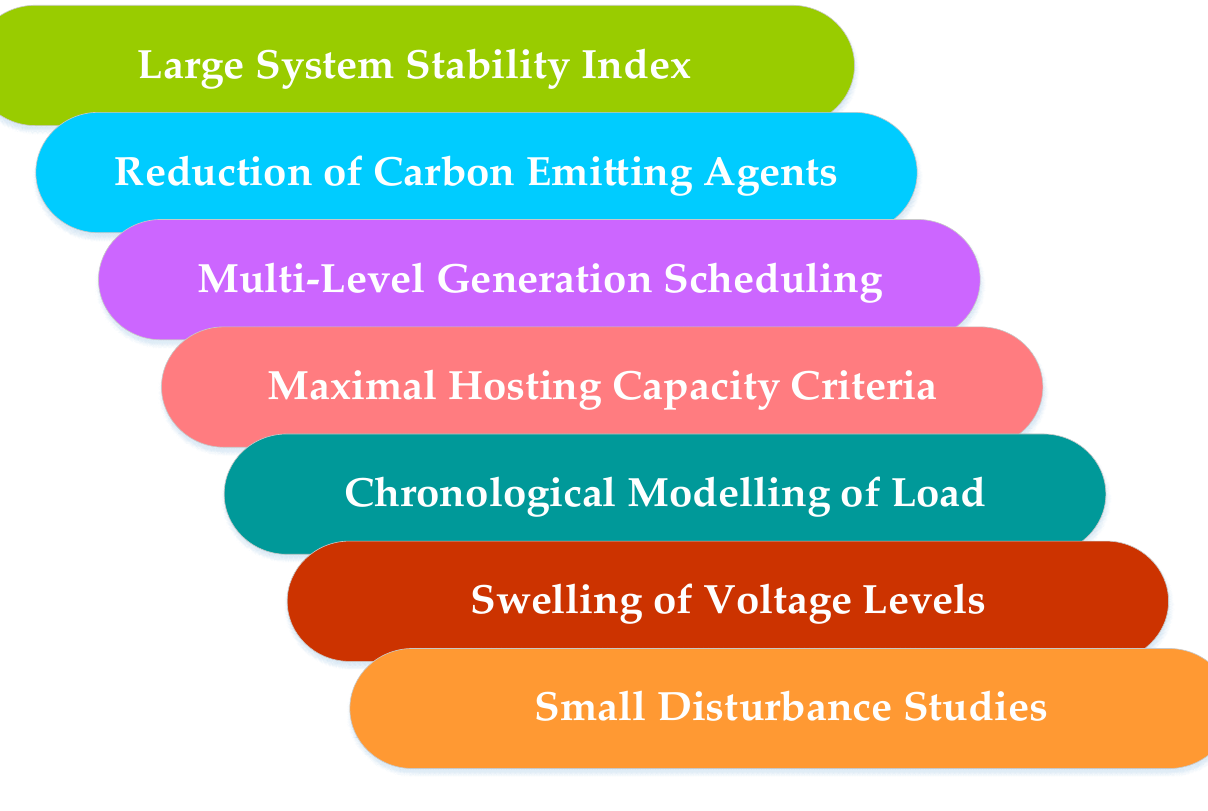
Figure 3. Meritorious perspective analysis on SG.